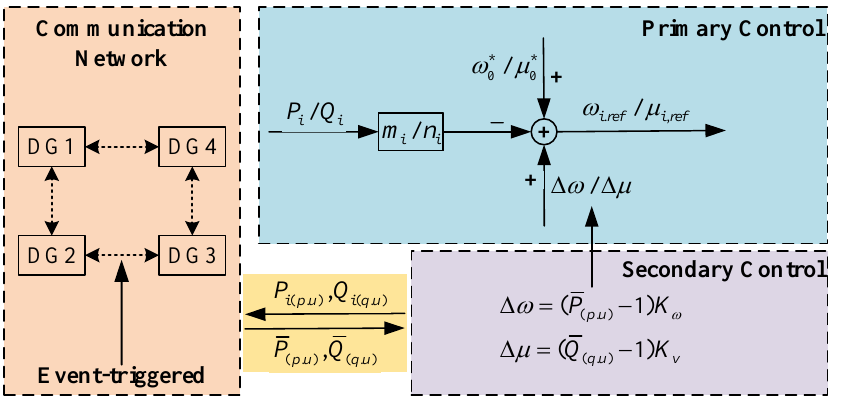
Figure 3. Secondary control block diagram.